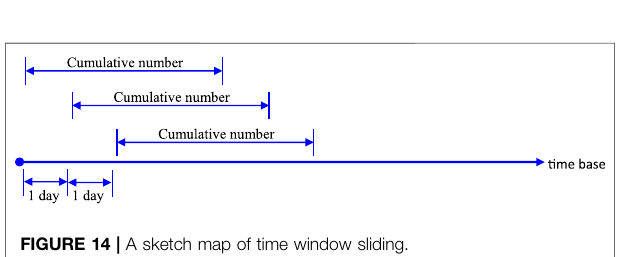
Figure 15 . It can be seen from the fi gure that before each rockburst, b value experienced a decline process, reaching a relatively low point in each stage, and then rising again. This process indicates that the number of major earthquake events in rock mass begins to increase. The proportion of increase, and the small-scale cracks merged. The spatial